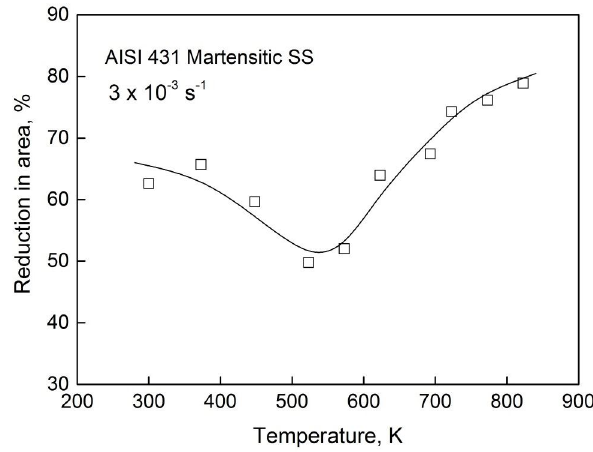
Figure 4: Variation of uniform elongation with temperature for the AISI 431 steel.